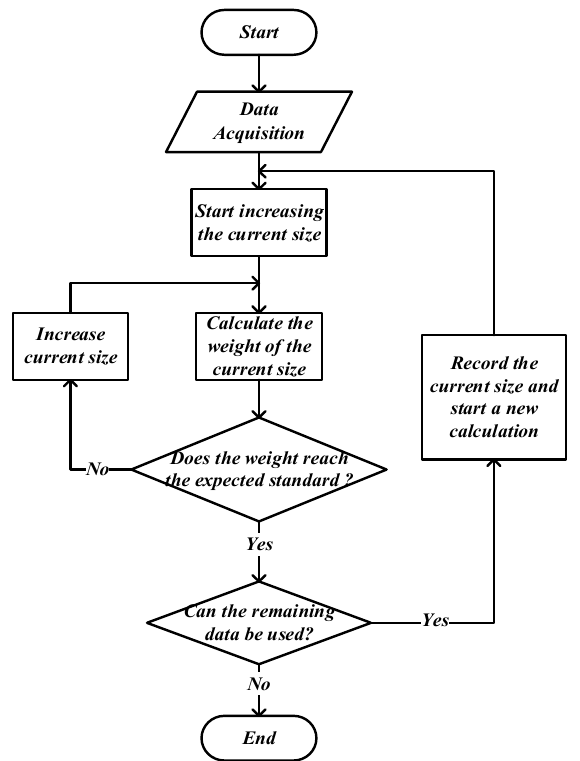
Figure 10. The calculation steps of the sequential algorithm.